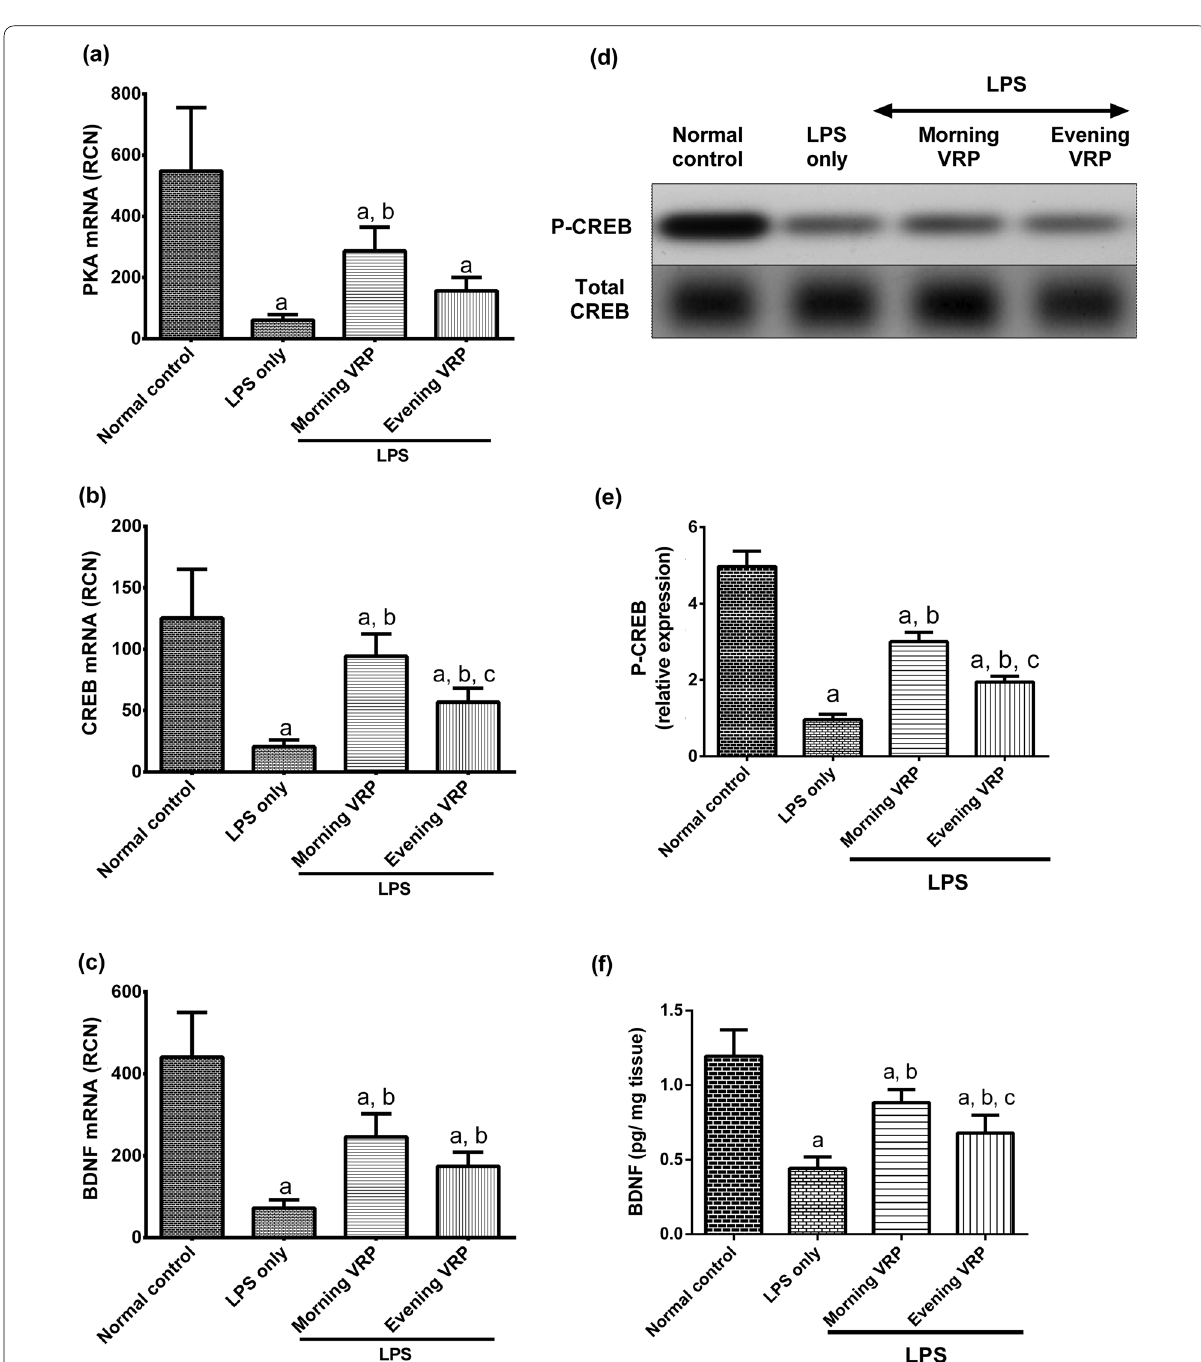
Fig. 10 Effect of VRP on PKA, CREB, and BDNF. a Expression level of PKA, b Expression level of CREB, c Expression level of BDNF, d Band intensity of P-CREB for one representative sample for each studied group normalized against total CREB, e Column chart for relative expression of P-CREB, and f Concentration of BDNF. Data are expressed as the mean SD and were analyzed using one-way ANOVA followed by Tukey post hoc test. Values ± were considered significantly different at P < 0.05. a: significant versus normal control, b: significant versus LPS only, and c: significant versus morning VRP. LPS: lipopolysaccharides, VRP: verapamil, PKA: protein kinase A, CREB: cAMP response element-binding protein, P-CREB: phosphorylated CREB, BDNF: brain-derived neurotrophic